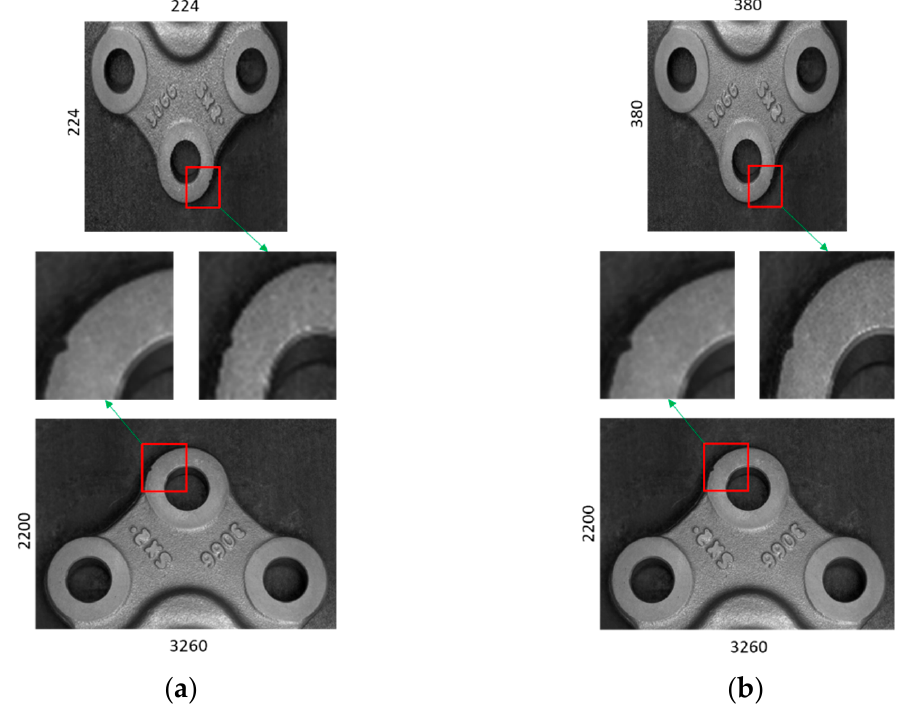
Figure 7. The impact of image size in small defects of the product in resizing of original image. ( a ) A resized image with 224 × 224 image size, ( b ) a resized image with 380 × 380 image size.